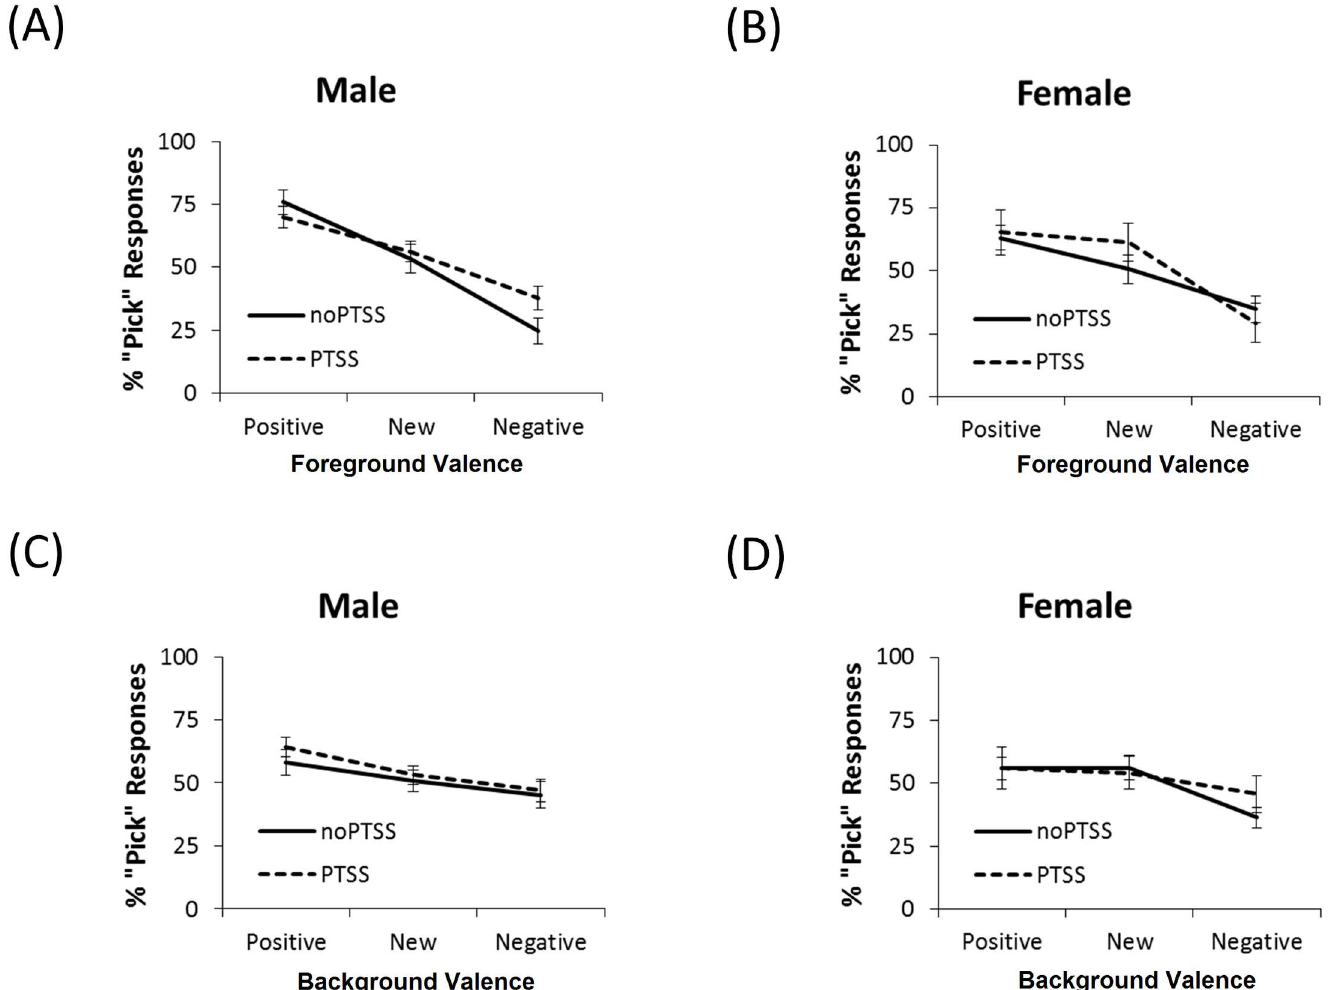
Fig 7. Percent “pick” responses as a function of gender, PTSS, foreground and background valence. (A) The noPTSS males show a decrease in “pick” responses from positive, to new, to negative foregrounds. PTSS males were similar, except that the difference betweenresponses to positive and new foregrounds did not reach significance. (B) Both noPTSS and PTSS females picked positive and new foregrounds more often than negative foregrounds. (C) Further examination of background valence effects indicatedthat, among noPTSS males, there was no significanteffect of background on responding,although in PTSS males, the difference betweenresponding to positive and negative backgrounds was significant.This effect, however, was small. (D) The noPTSS females made significantly more “pick” responseswith either the positive or new backgrounds comparedto the negative background. In contrast, PTSS females showedno effect of background on